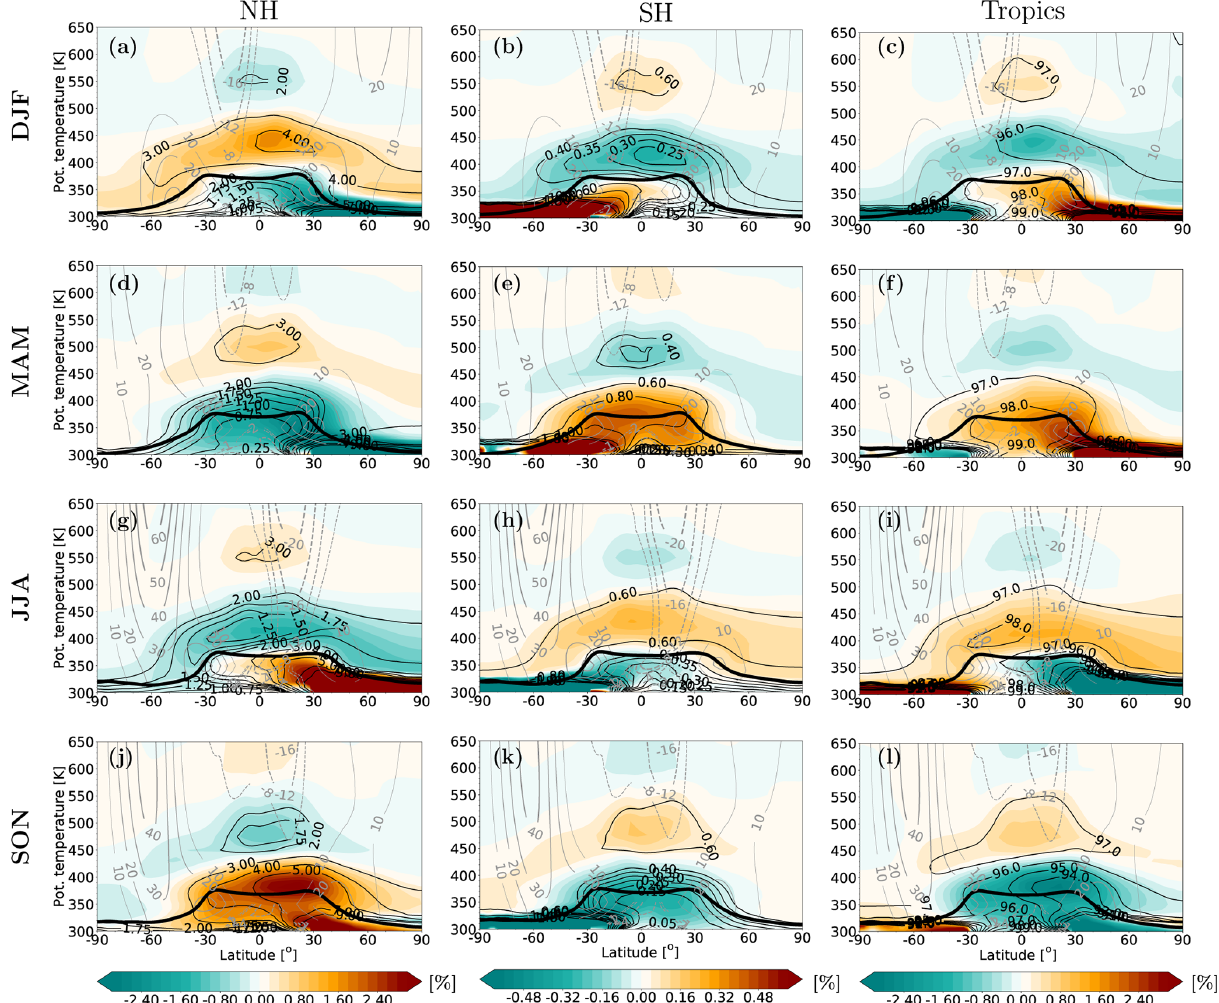
Figure 3. Climatological (1999–2017) zonal mean AMF departure from the annual average. The absolute AMF contributions from Fig. 1 are shown as black contours. Grey contours show the mean zonal winds. The thick black line is the WMO tropopause.